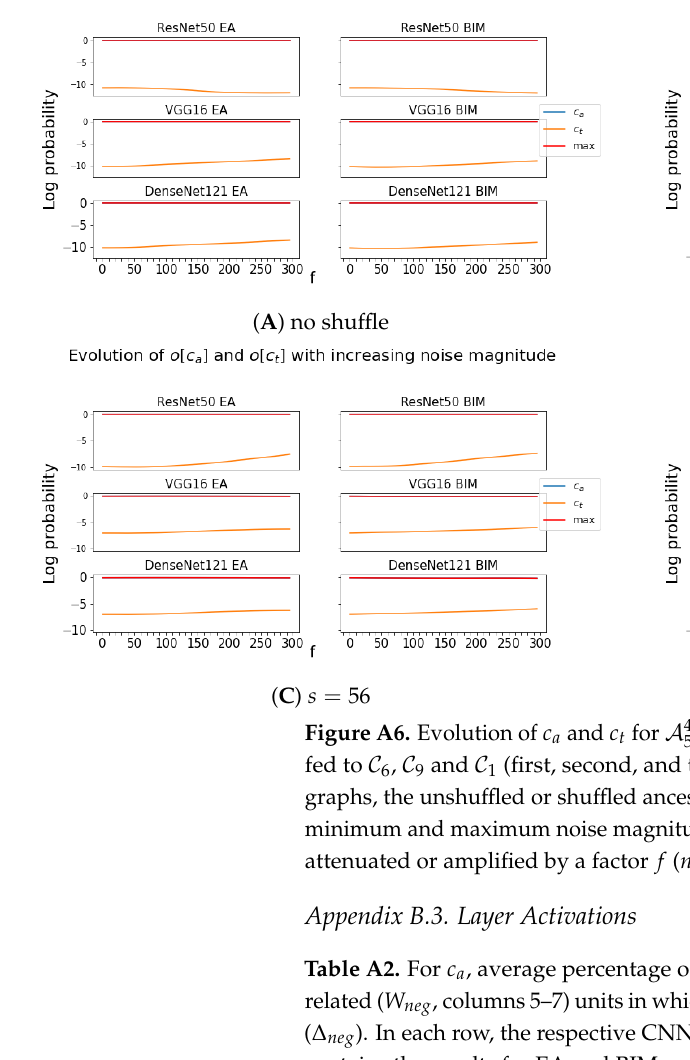
( A p ) . Each cell q 1